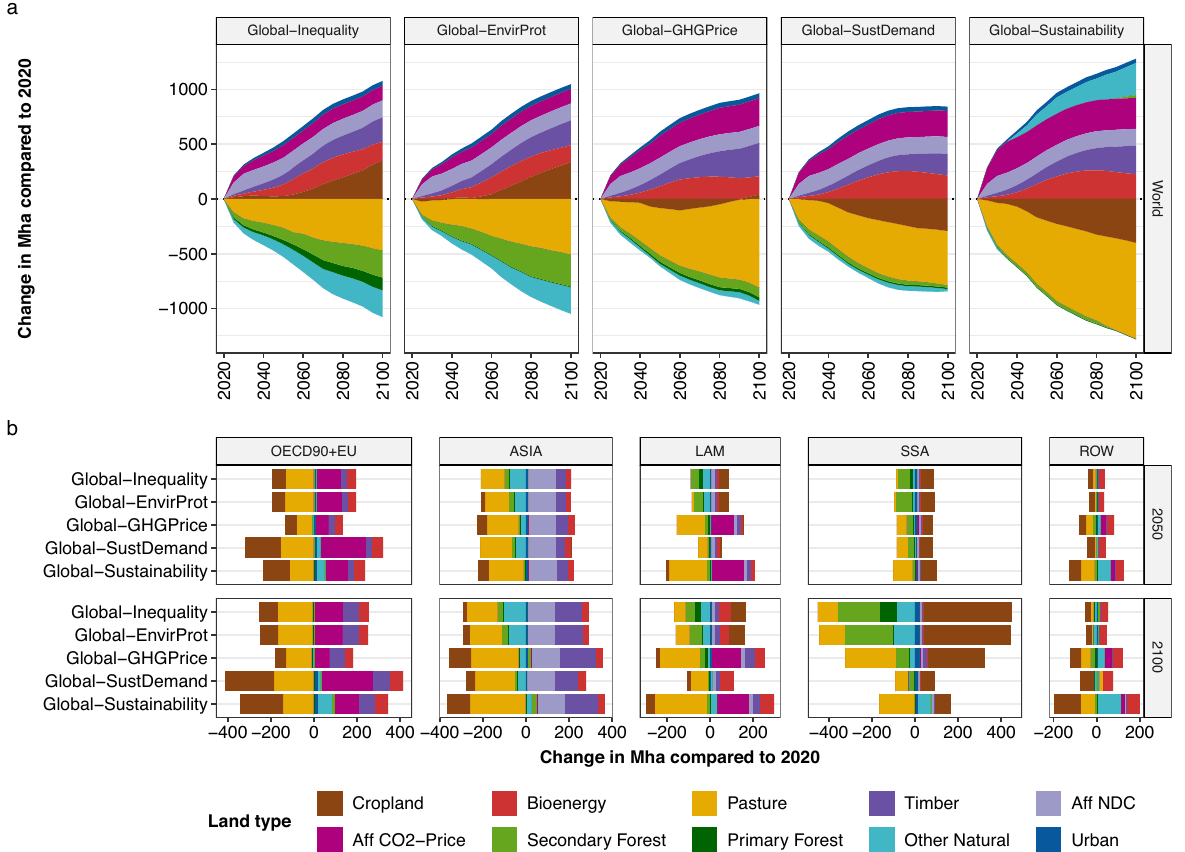
Fig. 4 | Land-use change of major land types over time compared to 2020 for fi ve scenarios. a show results at global level over time. b shows results at regional level for 2050 and 2100. Cropland includes food, non-food, and feed crops. Bioe- nergy includes 2nd generation bioenergy (fast growing grasses and trees such as miscanthus and poplar). Pasture includes rangeland and managed pasture areas. Timber refers to timber plantations for wood production. Aff NDC includes pre-